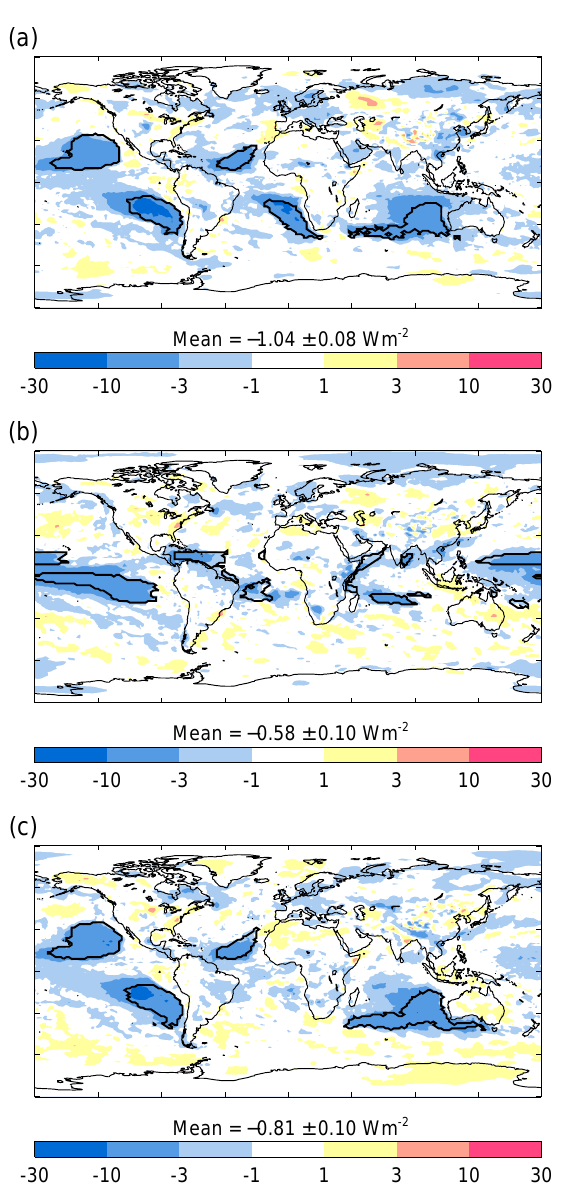
Fig. 3. RFPs due to geoengineered sea-spray aerosols using the dif- ferent emission patterns, indicated by the thick black lines, with the 10-year mean ± one standard deviation. (a) I-mask; (b) D-mask; (c) I-mask NSA .